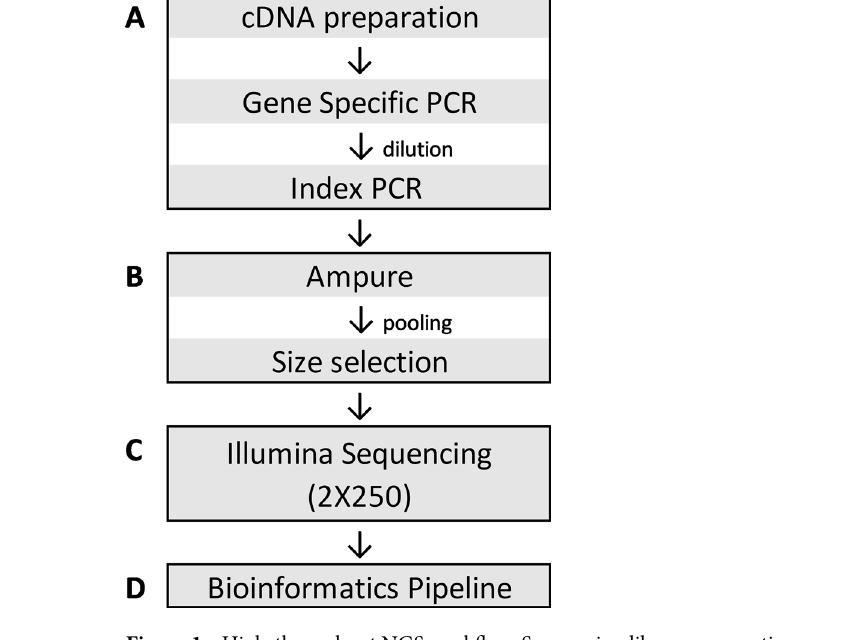
Figure 1. High-throughput NGS workflow. Sequencing library preparation was performed on robotic liquid handlers. ( A ) Extracted RNA of SARS-CoV-2 positive specimens were converted to cDNA and amplified